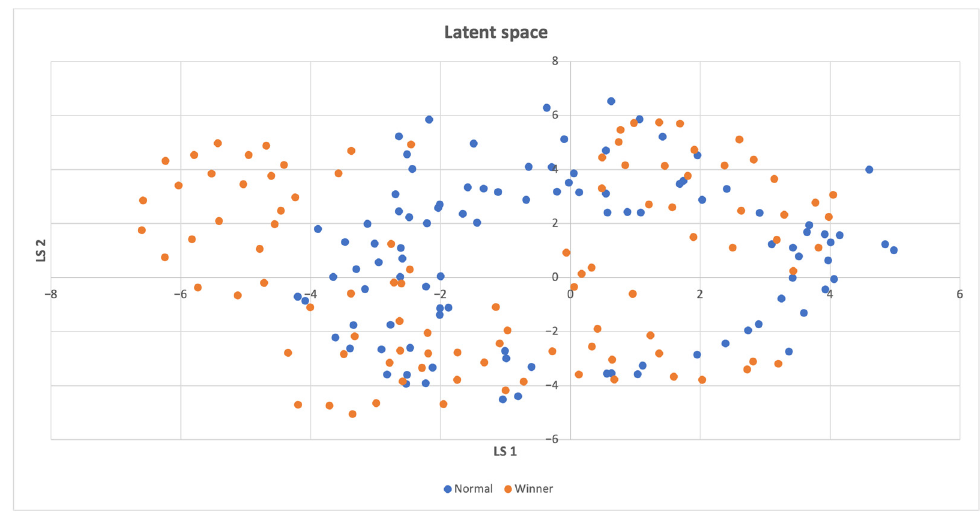
Figure 3. Latent space of the Acrobot-v1 environment, where a distinct cluster consisting of some of the winning states is located on the left.